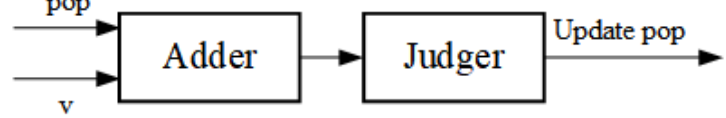
Figure 12. Particle position update module.